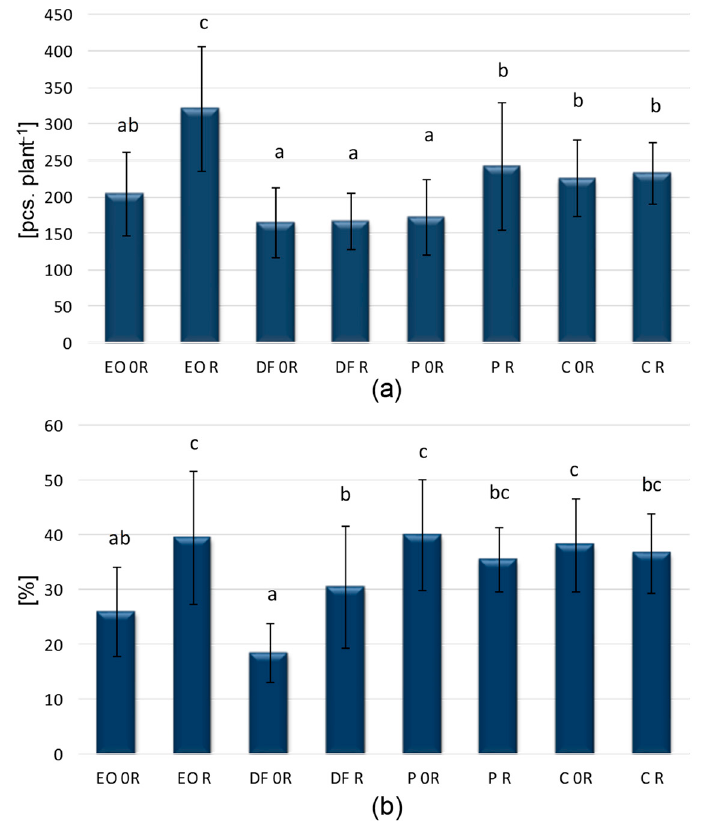
Figure 2. The effect of petroleum-derived substances and ZB-01 biopreparation on the number of Aphis fabae Scop. on broad bean plants (pcs. plant − 1 ) (average in the research season)—( a ) and the percentage of plants infested by Aphis fabae Scop. [%] (average in the research season)—( b ). Values marked with the same letters do not differ significantly according to LSD test at p < 0.05. Vertical bars mean SE (standard error). Symbols as in Figure 1. Table 1. The effect of petroleum-derived substances and ZB-01 biopreparation on the proportions of particular morphotic forms of Aphis fabae Scop. (% of the total number of aphids) (average in the research season).